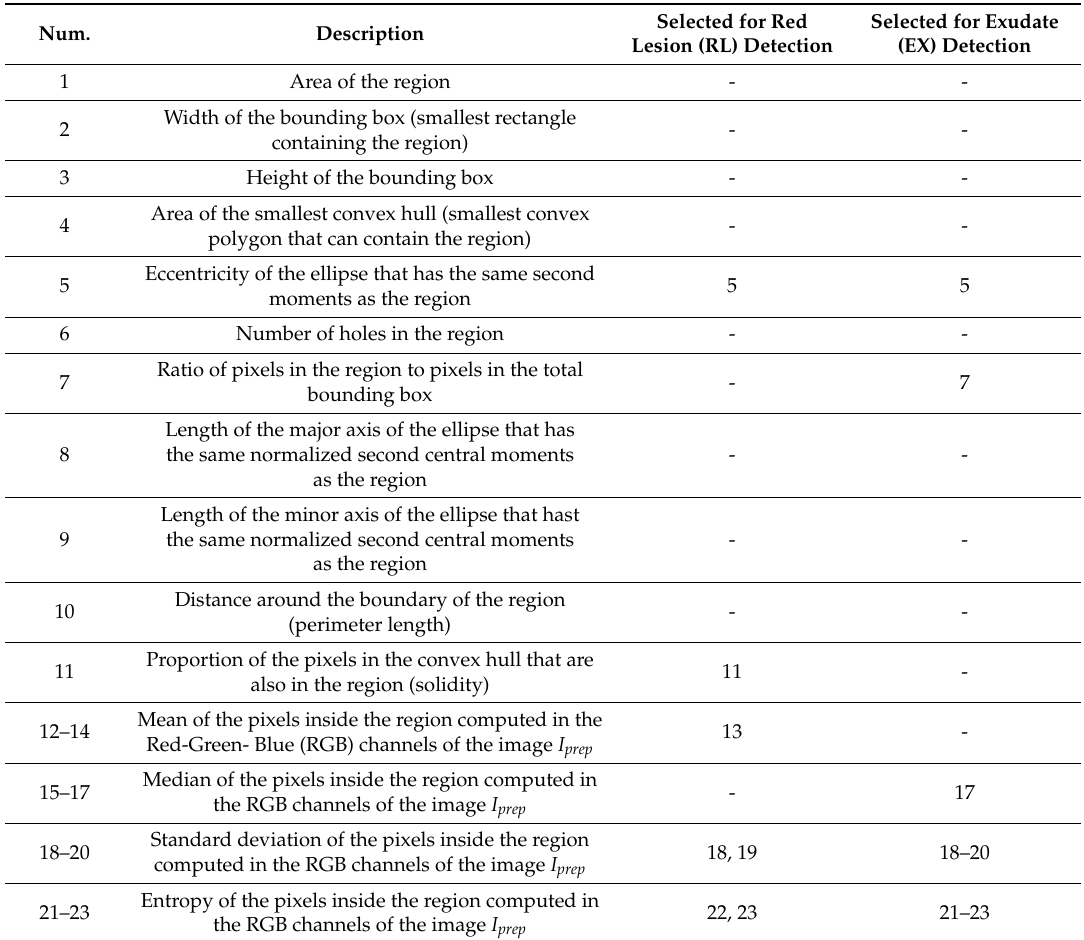
Table 1. Extracted features for lesion